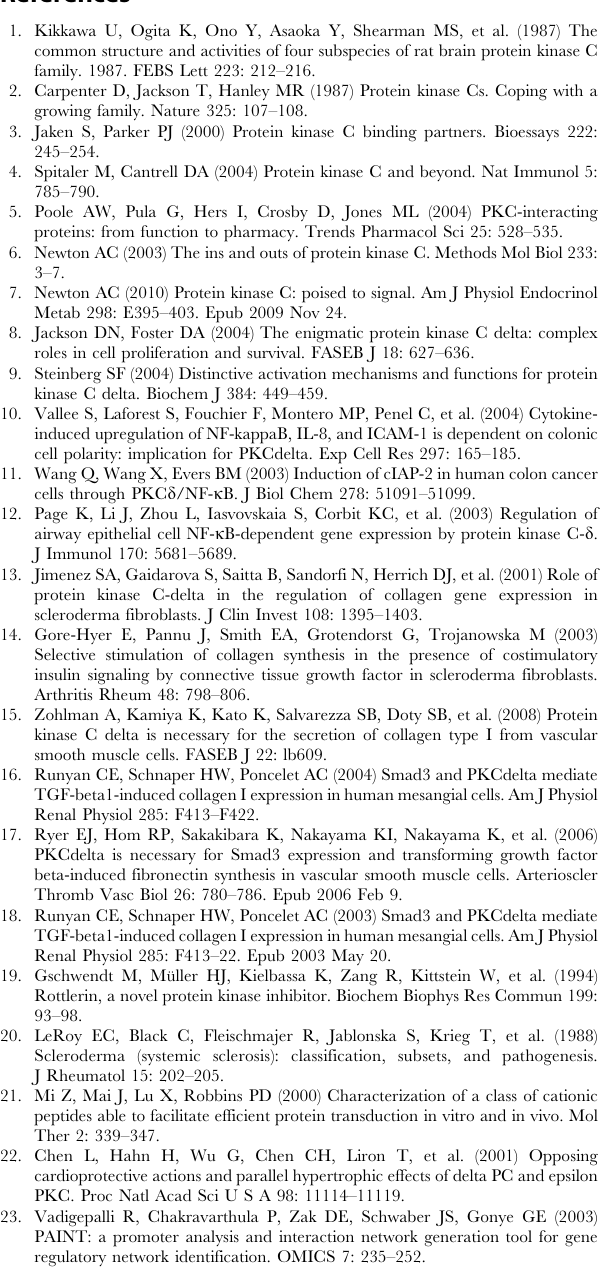
Table S1 Primers used for real-time PCR studies. PCR primers used to validate real-time PCR expression levels. Primers are listed in 5 9 -3 9 orientation. Table S2 PAINT analysis of enriched Transcriptional Regulatory Elements (TREs). PAINT v 3.9, containing a database of promoter sequences (UpstreamDB) constructed for all known and putative annotated genes in the Ensembl genome database for Homo sapiens , version 49, cross referenced